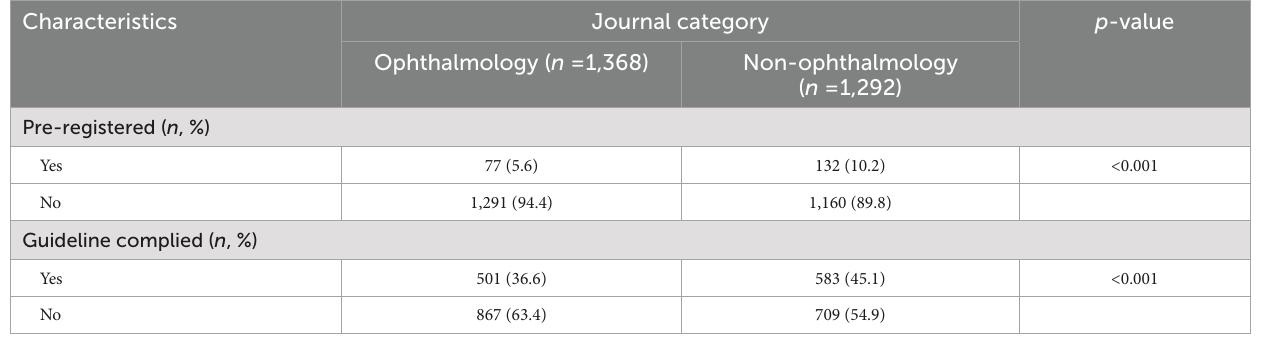
TABLE 1 Percentage of pre-registered and guideline complied studies published on ophthalmology versus non-ophthalmology journals.